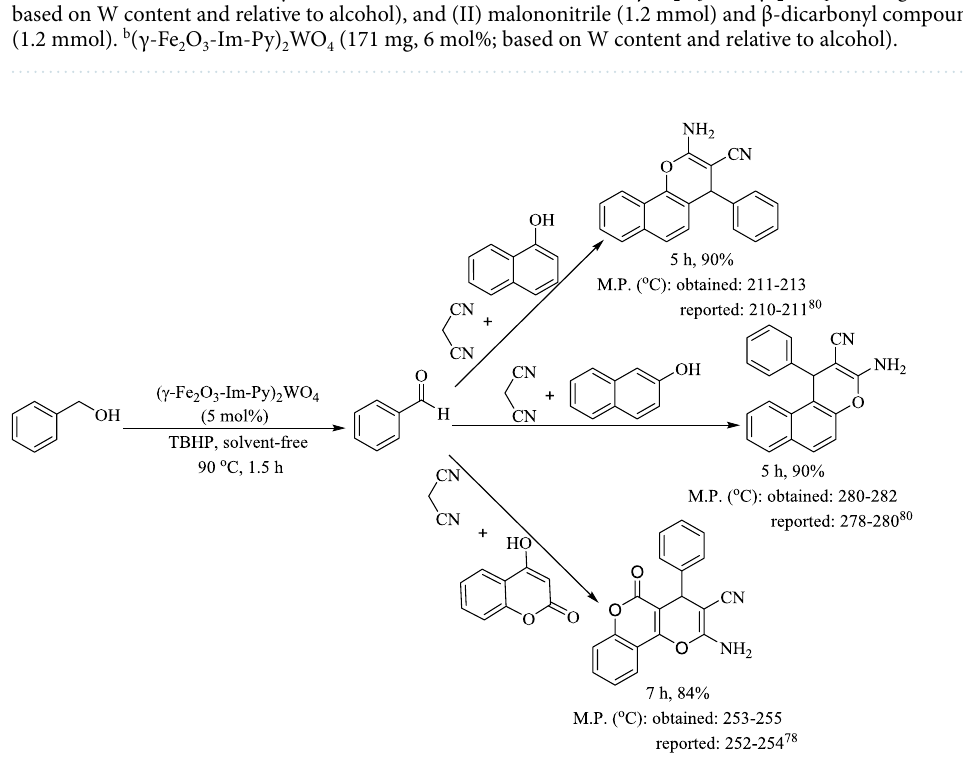
2 O 3 -Im-Py) 2 WO 4 (142 mg, 5 mol%;